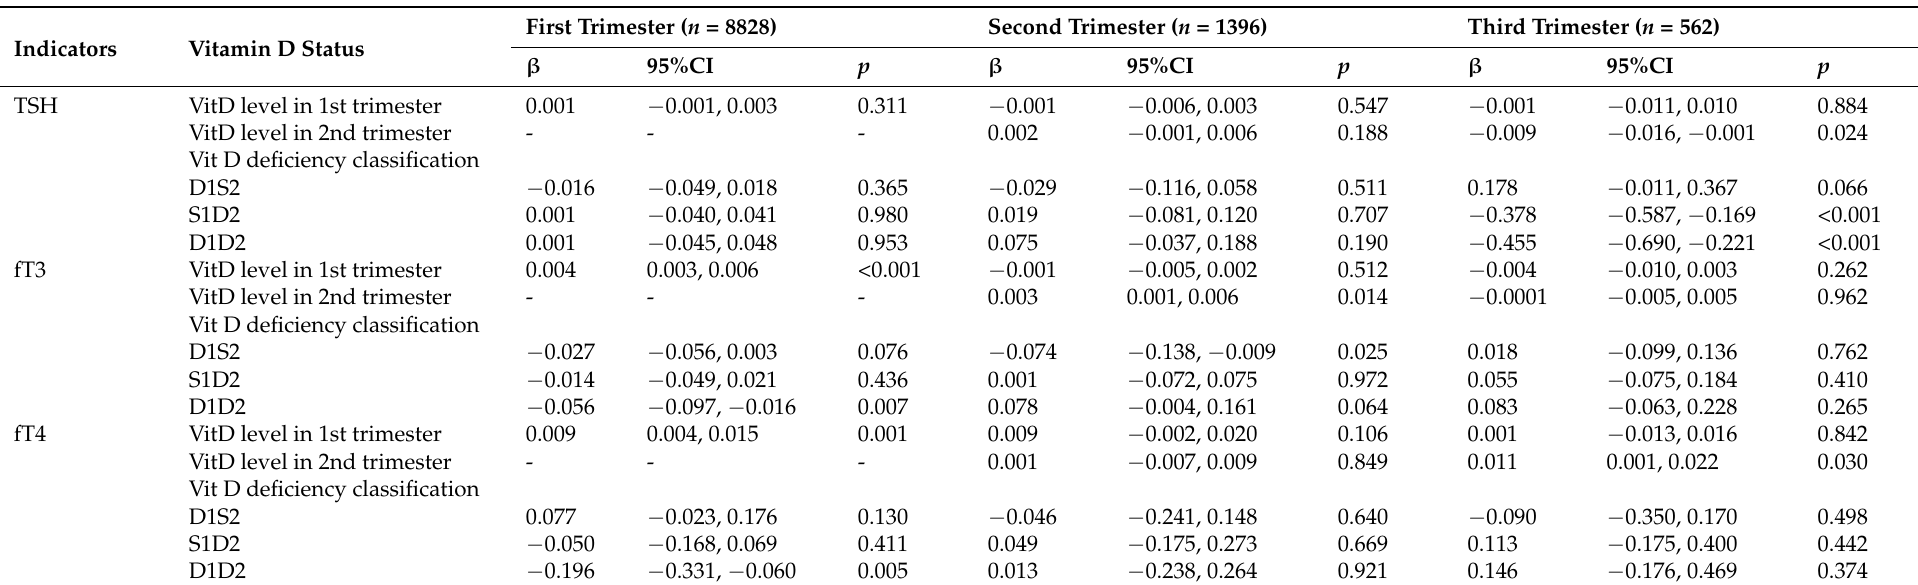
Table 3. Associations between VitD status and thyroid function parameter in each trimester 1